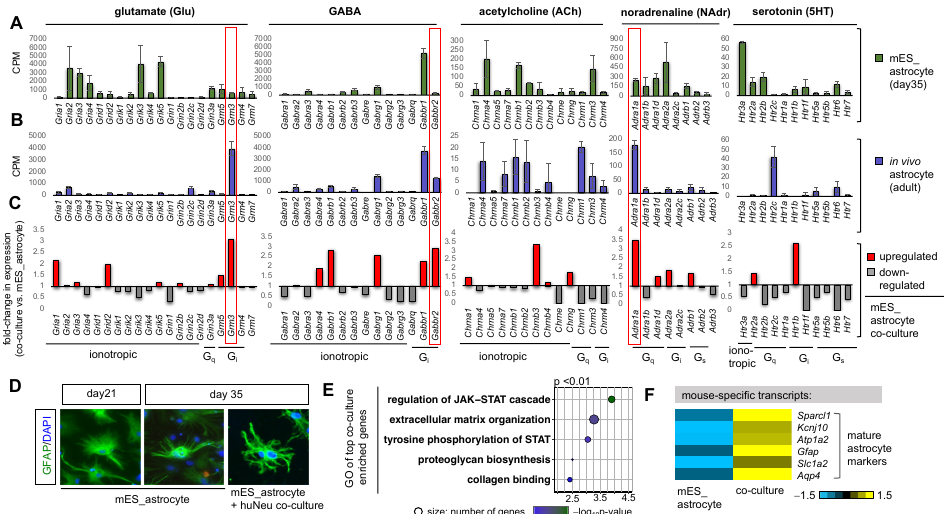
Figure 2. Neurons trigger the expression of distinct receptor subtypes in astrocytes and promote astrocyte development. Transcript expression levels of different receptor subtypes from RNA-Seq data of ( A ) day 35 mES_astrocytes and ( B ) 3–5-month-old adult astrocytes purified by FACS from Aldh1l1-GFP mice ( n = 3). Data are shown as the mean ± SD. ( C ) Average fold-change in the transcript expression of receptor subtypes in mES_astrocyte co-cultures versus mES_astrocyte control cultures. In vivo enriched receptor subtypes that are triggered by neuronal contact are highlighted in red boxes. ( D ) mES_astrocytes in co-cultures with neurons become morphologically complex in comparison to control cultures, as observed by GFAP immunolabeling. ( E ) GO terms of top genes that are enriched in co-cultures ( p < 0.01). ( F ) Heatmap showing that mature astrocyte markers are enriched in mES_astrocyte co-cultures in comparison to control mES_astrocyte